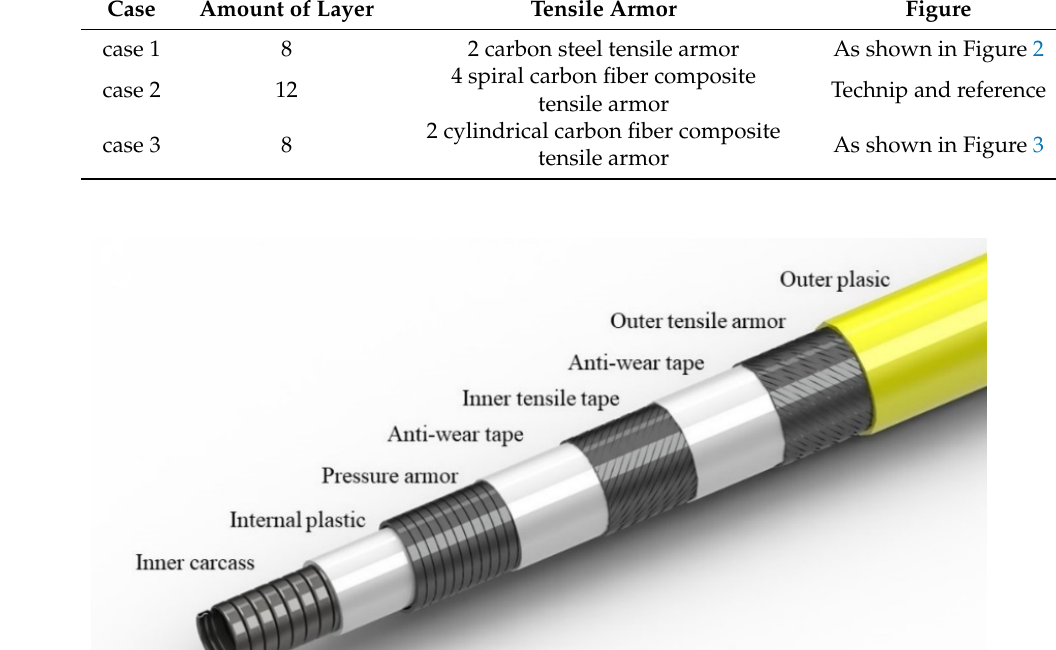
Table 2. Geometric parameters of flexible risers tested.